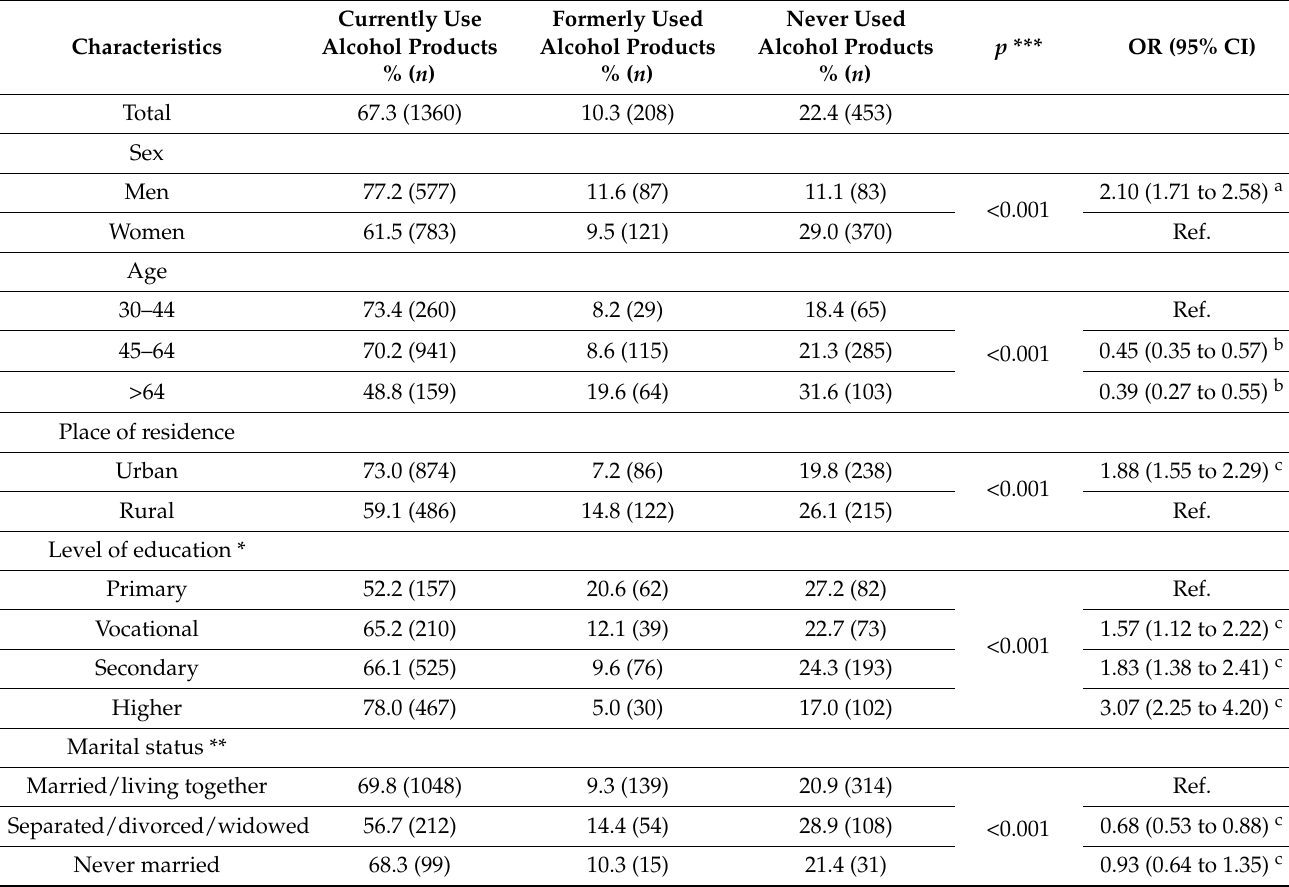
Table 1. Sociodemographic characteristics of attitudes toward alcohol drinking in the PURE Poland cohort study.